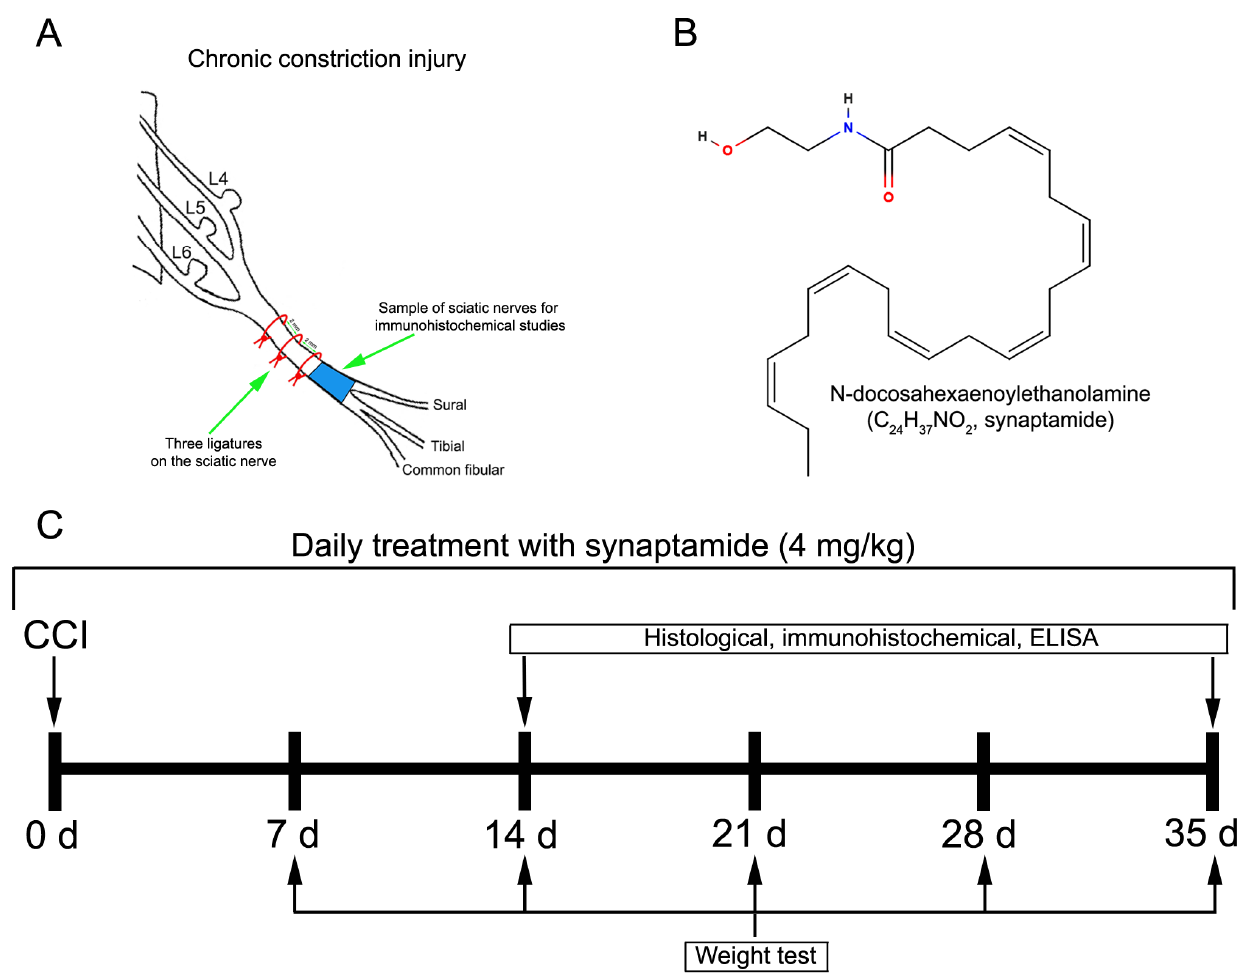
Figure 7. ( A ) Chronic constriction injury of the sciatic nerve. ( B ) Chemical structure of N-docosahexaenoylethanolamine (DHEA, synaptamide). ( C ) Timeline of the experiments.